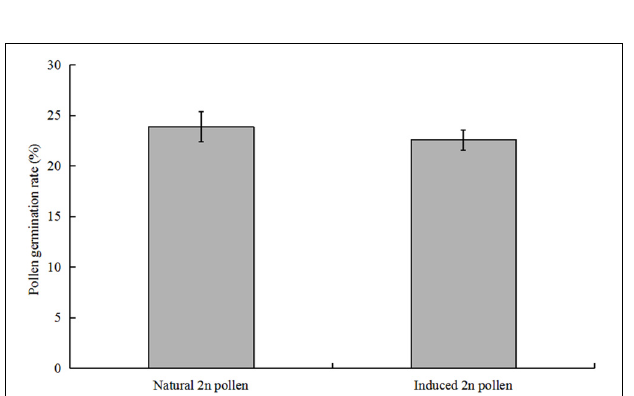
FIGURE 6 | Lengths of the pollen tubes of haploid pollen and colchicine-induced 2n pollen derived from the treatment given 11 injections with 0.5% colchicine at pachytene in P. canescens . Lowercase letters represent significant differences at ( P < 0.05).